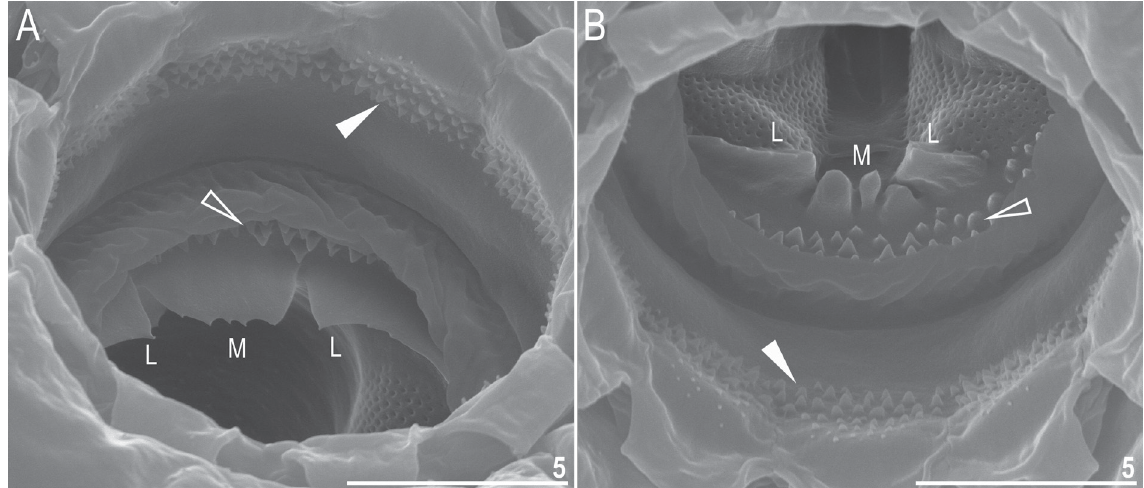
Fig. 11. Macrobiotus cf. recens Cuénot, 1932 , Gran Canaria, oral cavity armature seen under SEM from different angles. A . View of the dorsal portion. B . View of the ventral portion. Filled arrowheads indicate the teeth of the first band, empty arrowheads indicate the teeth of the second band, median teeth are marked with M, and lateral teeth are marked with L. Scale bars in μm.